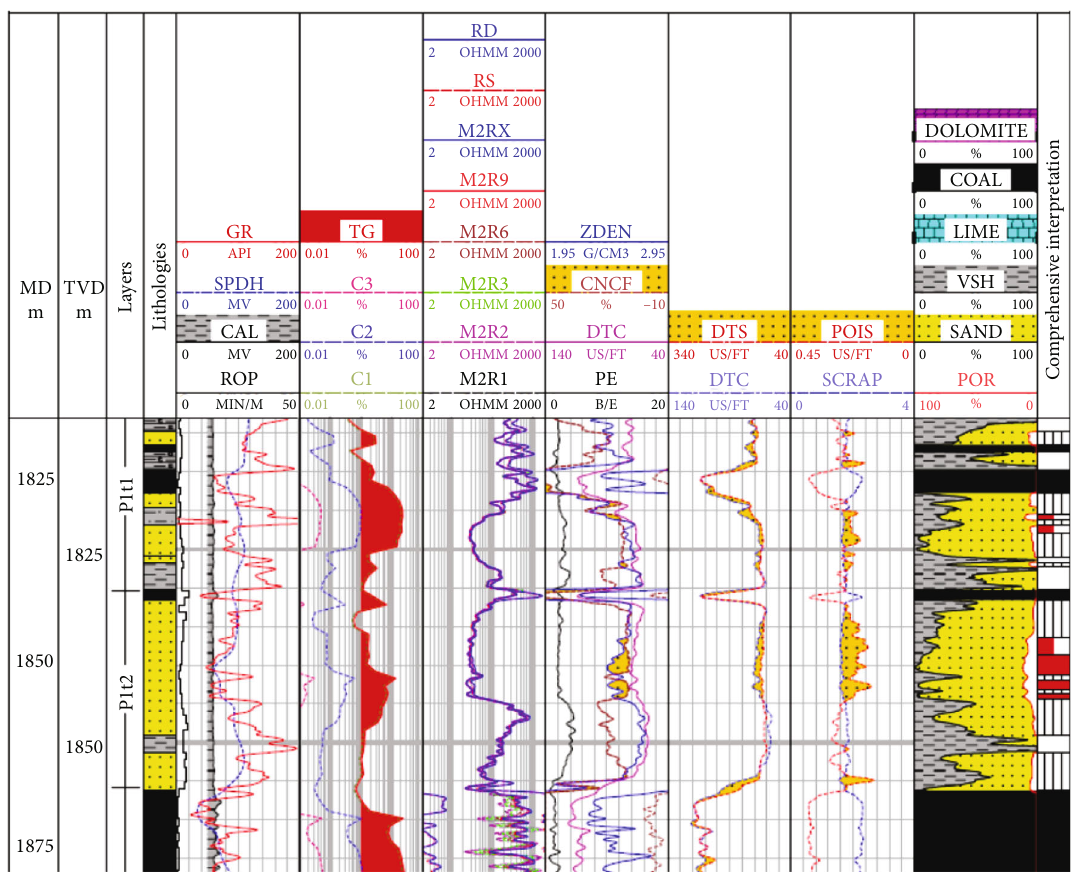
Figure 14: Well-logging curve in the Taiyuan formation of well